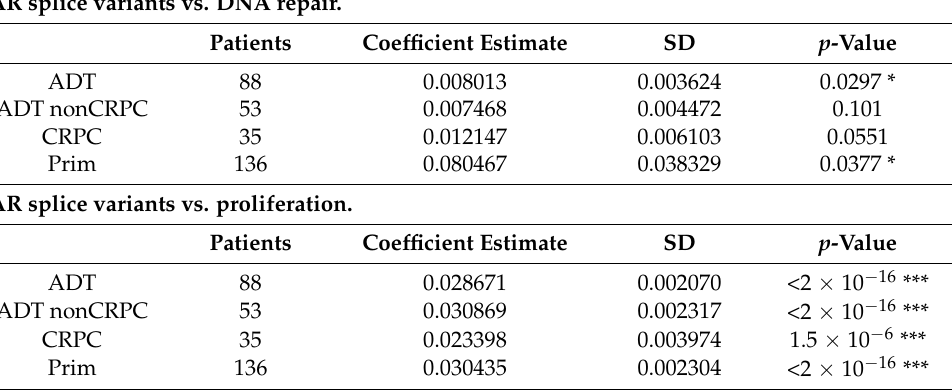
Figure 6. ( A ) Distribution of DNA repair scores in study groups (cumulative score based on mRNA expression of 20 DNA repair genes). Light blue points express any of the AR-V splice variants (V1, V3, V7, V9); dark blue points do not express AR-V splice variants. ( B ) Dependence of DNA repair score on the presence of AR-V splice variants (V1, V3, V7, V9) in ADT and CRPC groups. p -levels calculated using Mann–Whitney U-test. Statistical significance ( p < 0.05): * vs. PRIM group, # vs. CTRL group. ( C ) Correlation analysis shows dependence of the AR score and DNA repair score in PRIM, ADT and CRPC groups. Table 2. Estimates of associations between AR splice variants, proliferation and DNA repair, as obtained from fitting group-wise linear regression models with the DNA-R score as a dependent variable and splice variant and proliferation scores as independent variables. * p < 0.05, *** p < 0.0005. AR splice variants vs. DNA repair.